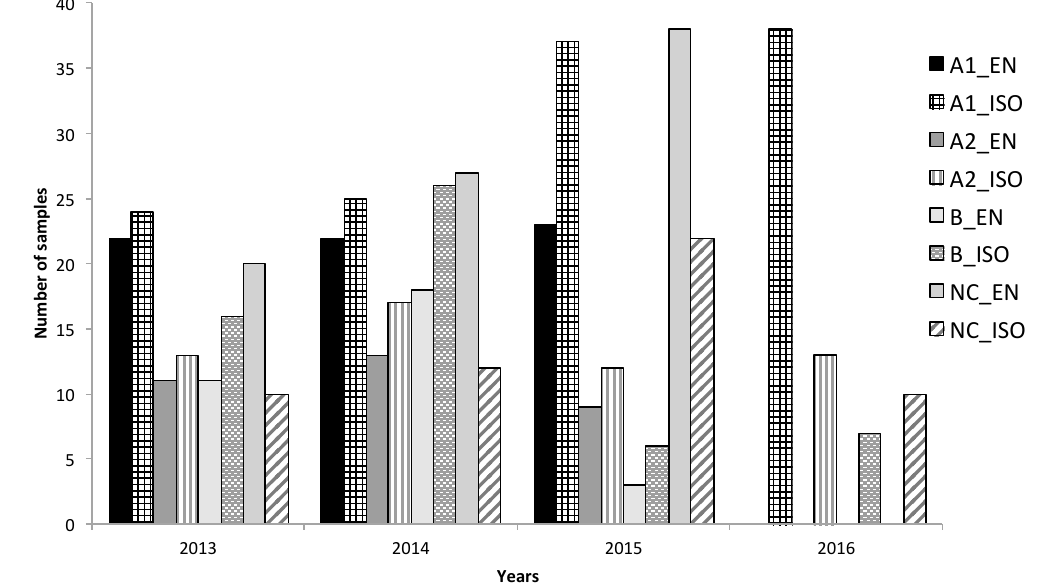
Figure 1. Changes in wood chips quality with the entry in force of the ISO classification over the years of analysis.